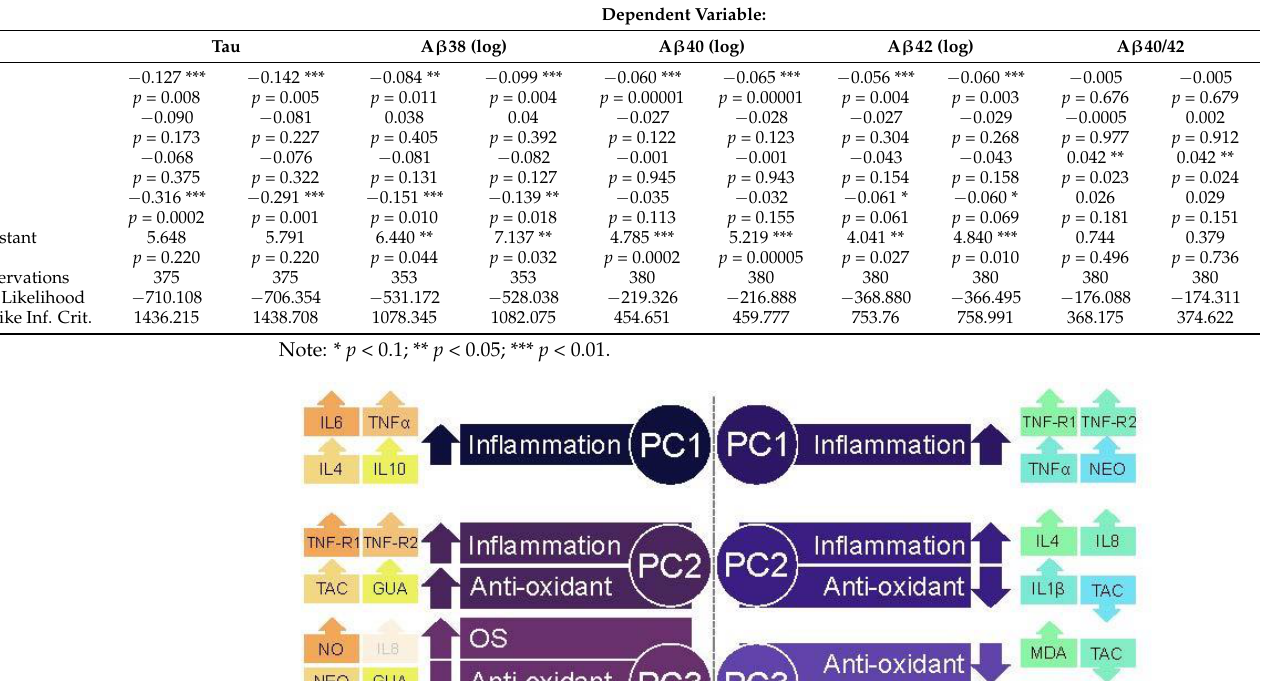
Table 3. Associations between principal components of oxidative stress and inflammation and AD biomarkers in the 60s.